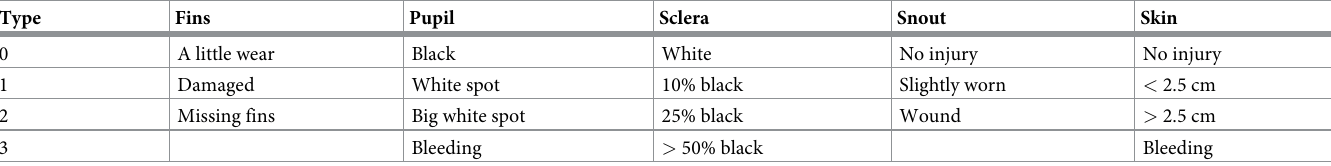
Table 2. Operational welfare scores